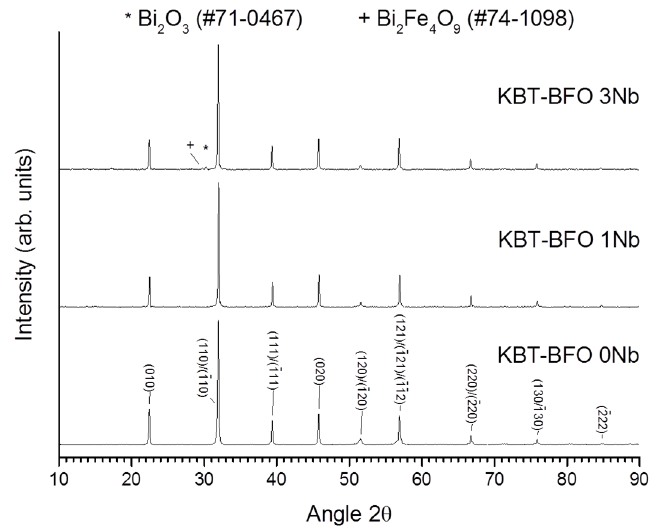
Figure 2. XRD traces of 0.4(K 0.5 Bi 0.5 )Ti (1 − x ) Nb x O 3 ‐ 0.6BiFe (1 − x ) Nb x O 3 samples after sintering at 1050 °C for 1 h.